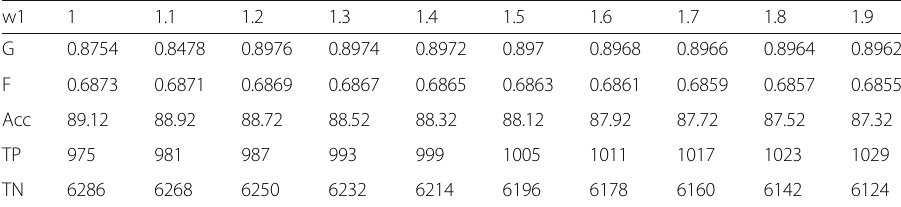
Table 5 DWSVM model w1 selection